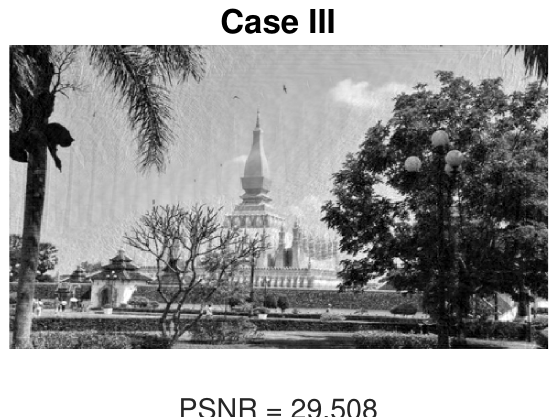
Figure 17. The reconstructed grey image with their PSNRs for three different cases using the proposed algorithm presented in 10,000 iterations, respectively.